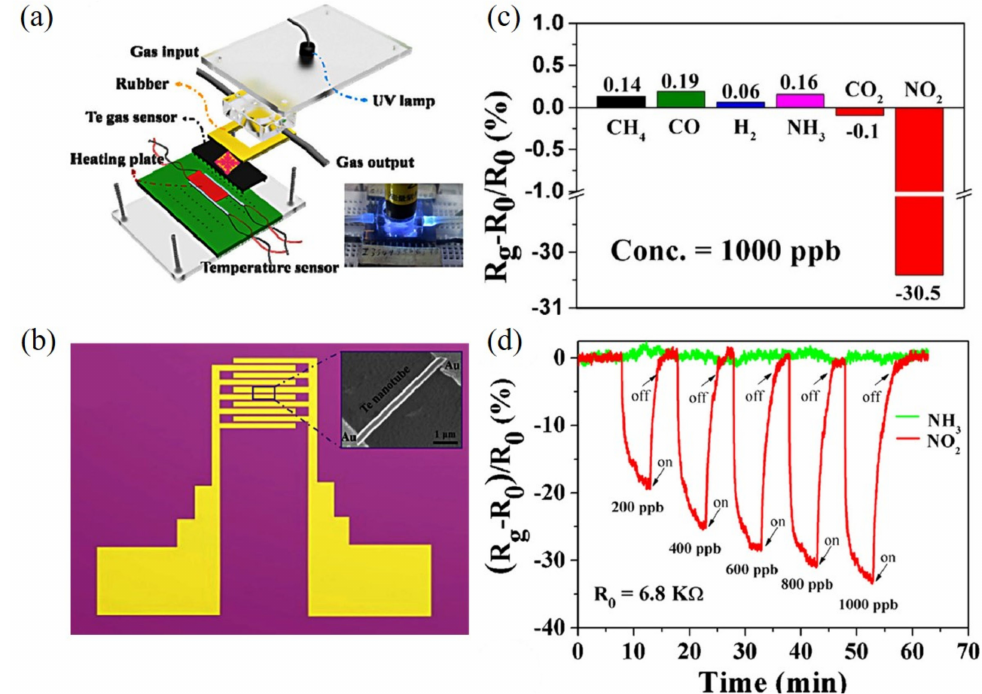
Figure 9. ( a ) The schematic and photographs (inset) of a customized chemiresistive sensor based on Te NTs, and ( b ) the schematic of an independent interdigitated electrode. Inset in ( b ) is a SEM picture of one Te nanotube on an interdigitated electrode. ( c ) Real-time response of the gas sensor toward NH 3 and NO 2 , and ( d ) response of the sensor to different gases that have a concentration of 1000 ppb. Reprinted with permission from [2]. Copyright 2014, Elsevier B.V., Amsterdam, the